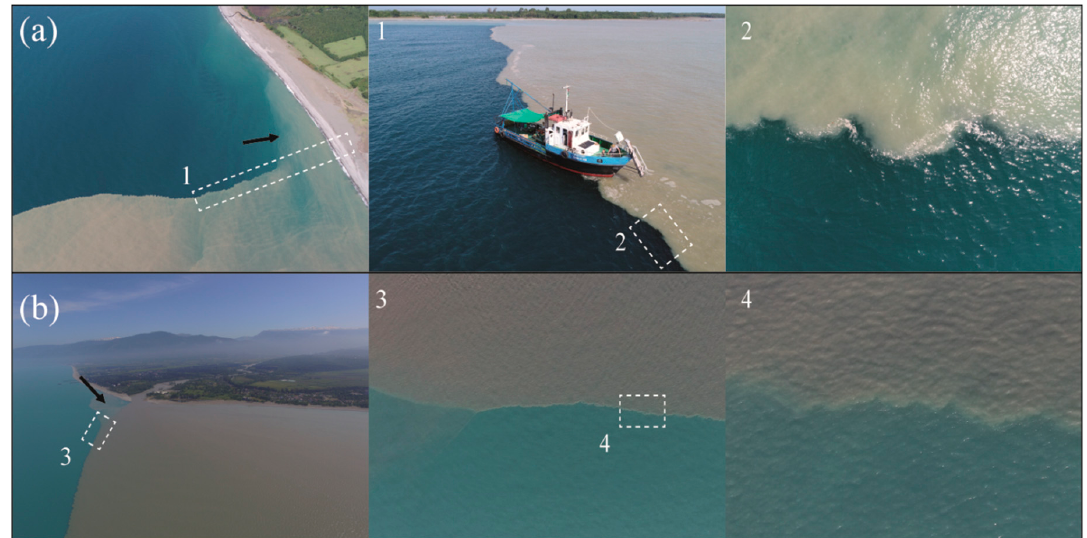
Figure 12. Aerial images ( a ) of undulate fronts at the border of the Kodor plume on 1 September, 2018 and ( b ) at the border of the Bzyp plume on 1 June, 2019. Central and right pictures at panel ( a ) are the zoomed fragments of the left and central pictures at panel ( a ), respectively, indicated by the white dashed rectangles 1 and 2, respectively. Central and right pictures at panel ( b ) are the zoomed fragments of the left and central pictures at panel ( b ), respectively, indicated by the white dashed rectangles 3 and 4, respectively. Black arrows indicate absence of undulate fronts at the surf zone.